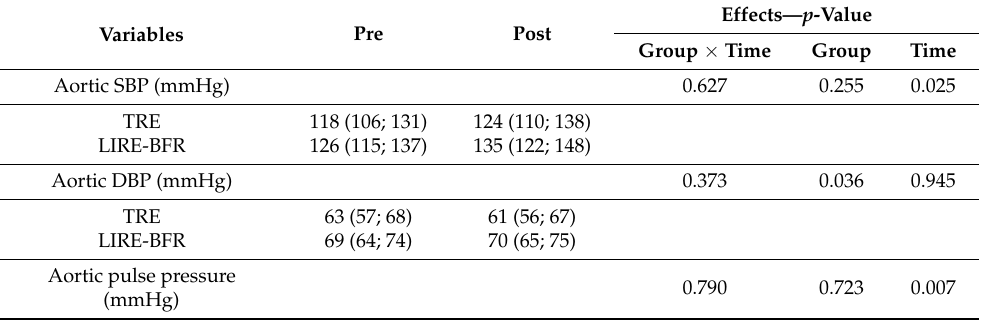
Table 2. Arterial stiffness